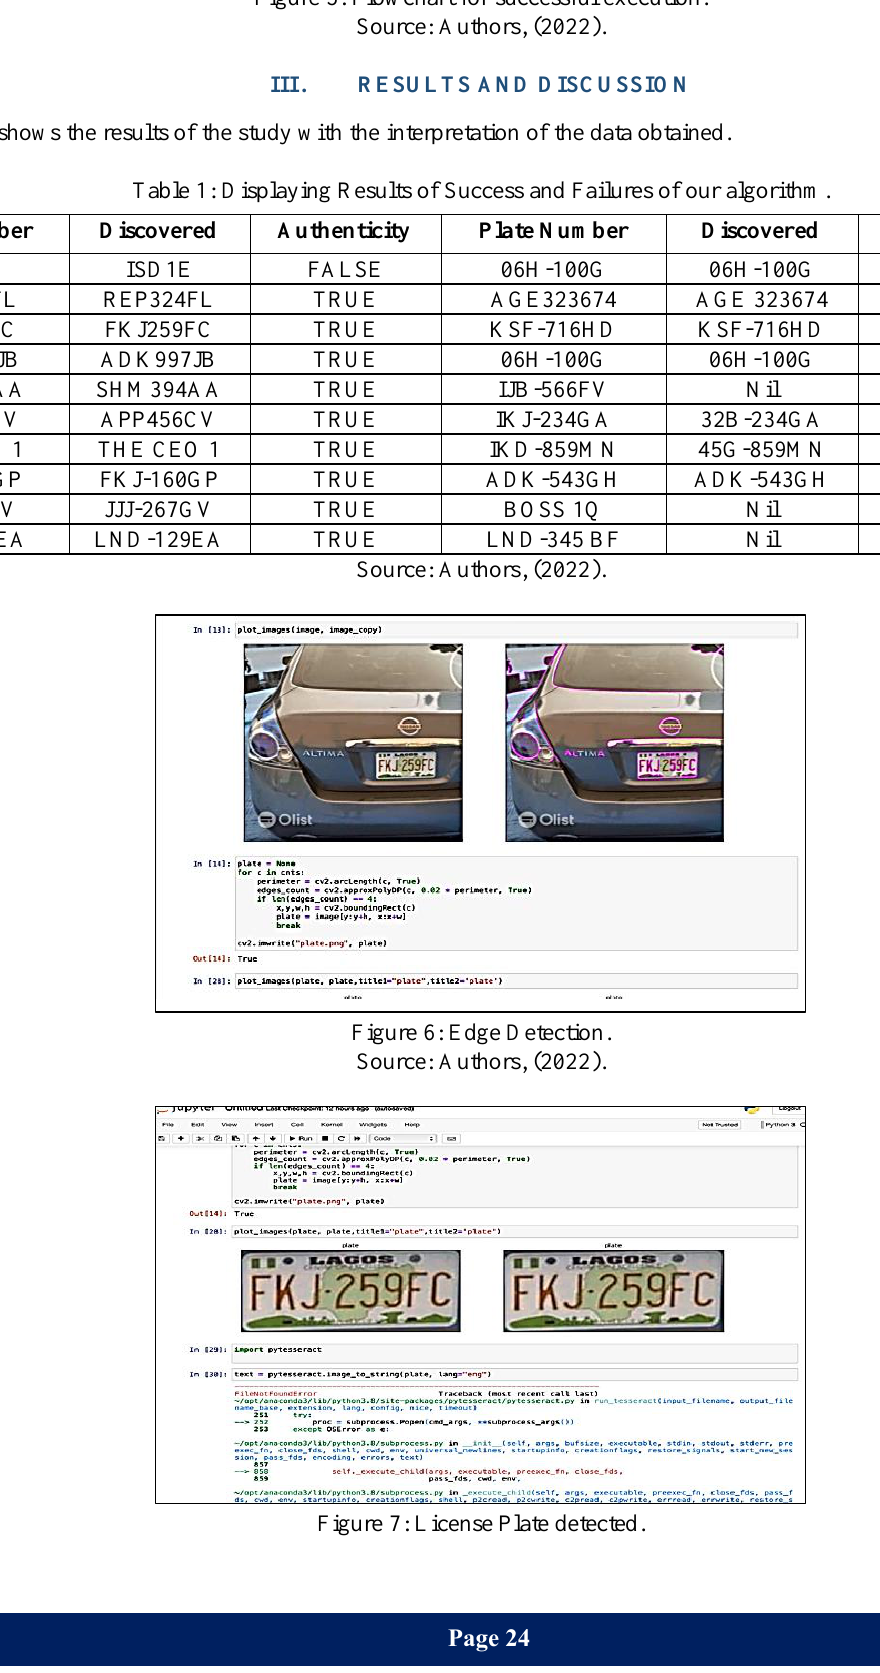
Figure 5: Flowchart for successful execution.